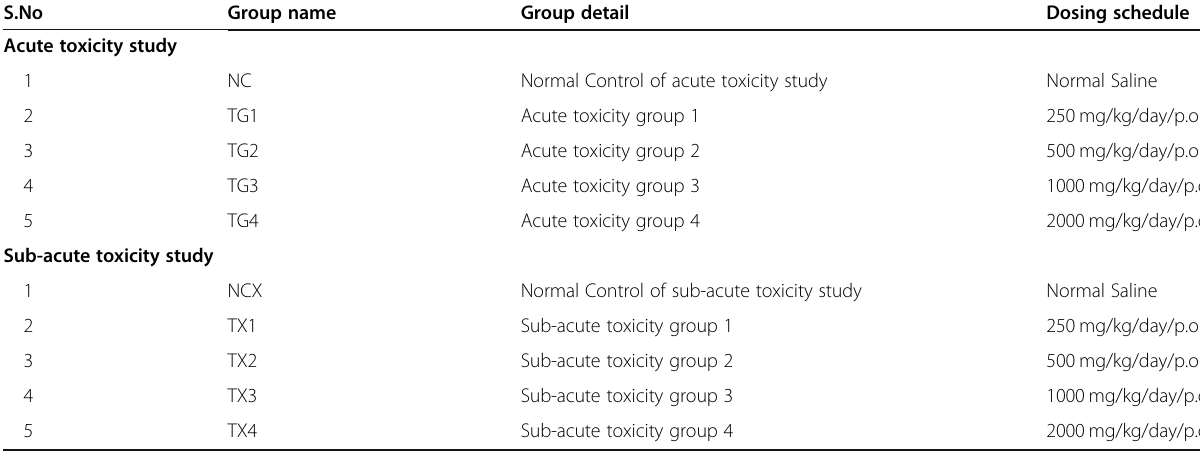
Table 1 Dosing protocol of polyherbal combination (PHC) to female swiss albino mice for acute and sub-acute toxicity study